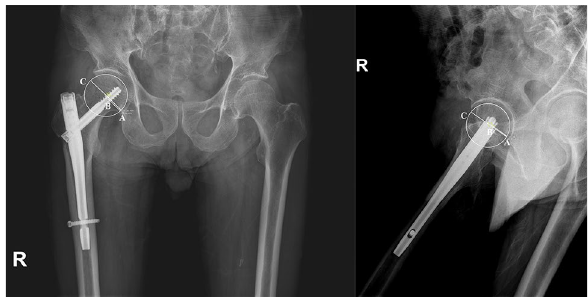
Figure 3. Assessment of the Parker’s ratio in the anterior–posterior plane and the lateral plane. The Parker’s ratio is represented by the percentage AB/AC × 100.